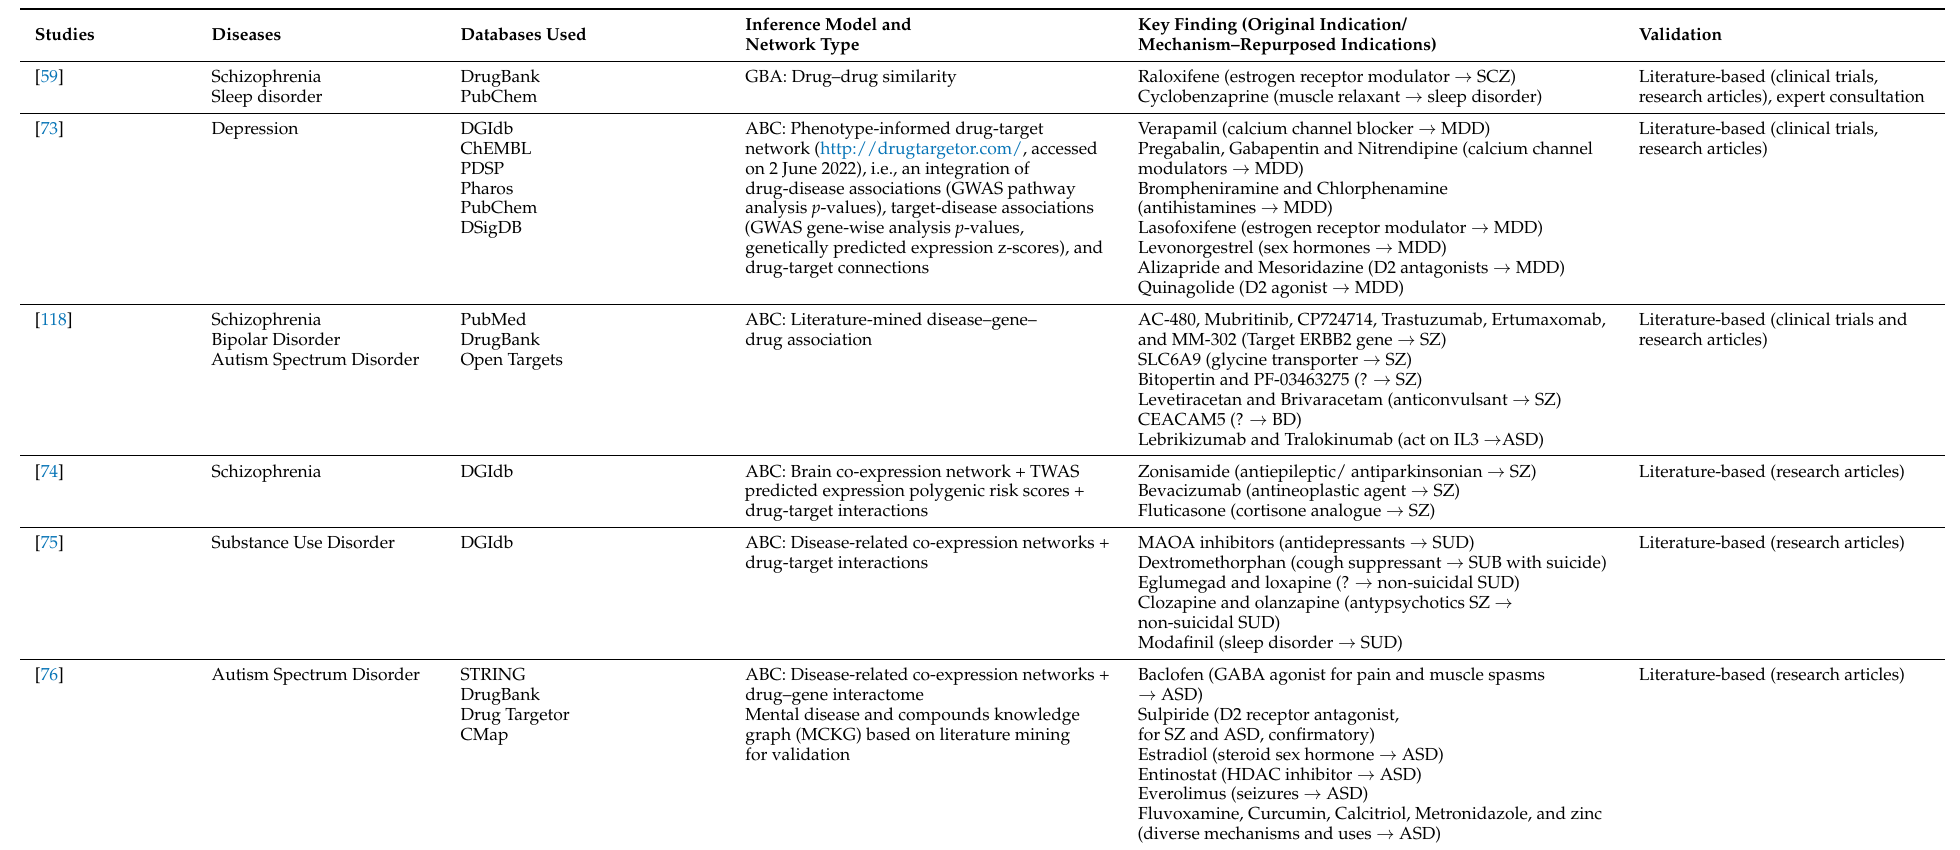
Table 2. Summary of studies using network-based drug repurposing for psychiatric disorders. Abbreviations: ABC: ABC model; ASD: autism spectrum disorder; ADHD: attention-deficit/hyperactivity disorder; BD: bipolar disorder; GBA: guilt-by-association model; MDD: major depressive disorder; SCZ: schizophrenia; SUD: substance use disorder; TWAS: transcriptome-wide association study; ?: unclear